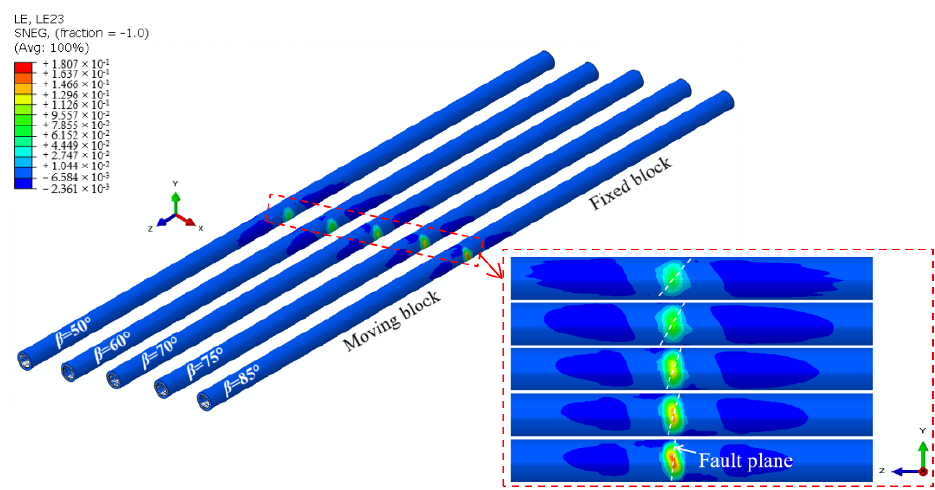
Figure 8. Circumferential shear strain nephogram with different fault dip angles ( ∆ f = 8 cm and stiff).